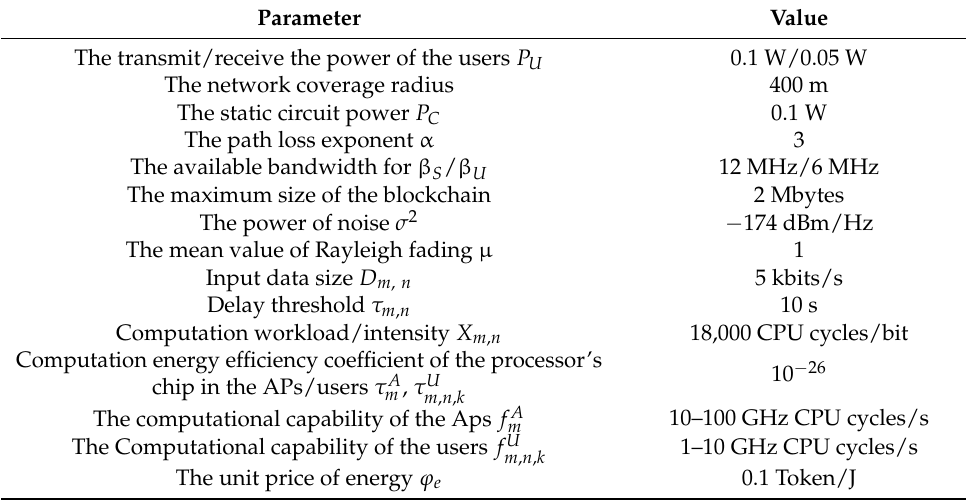
Table 3. Environment setup.